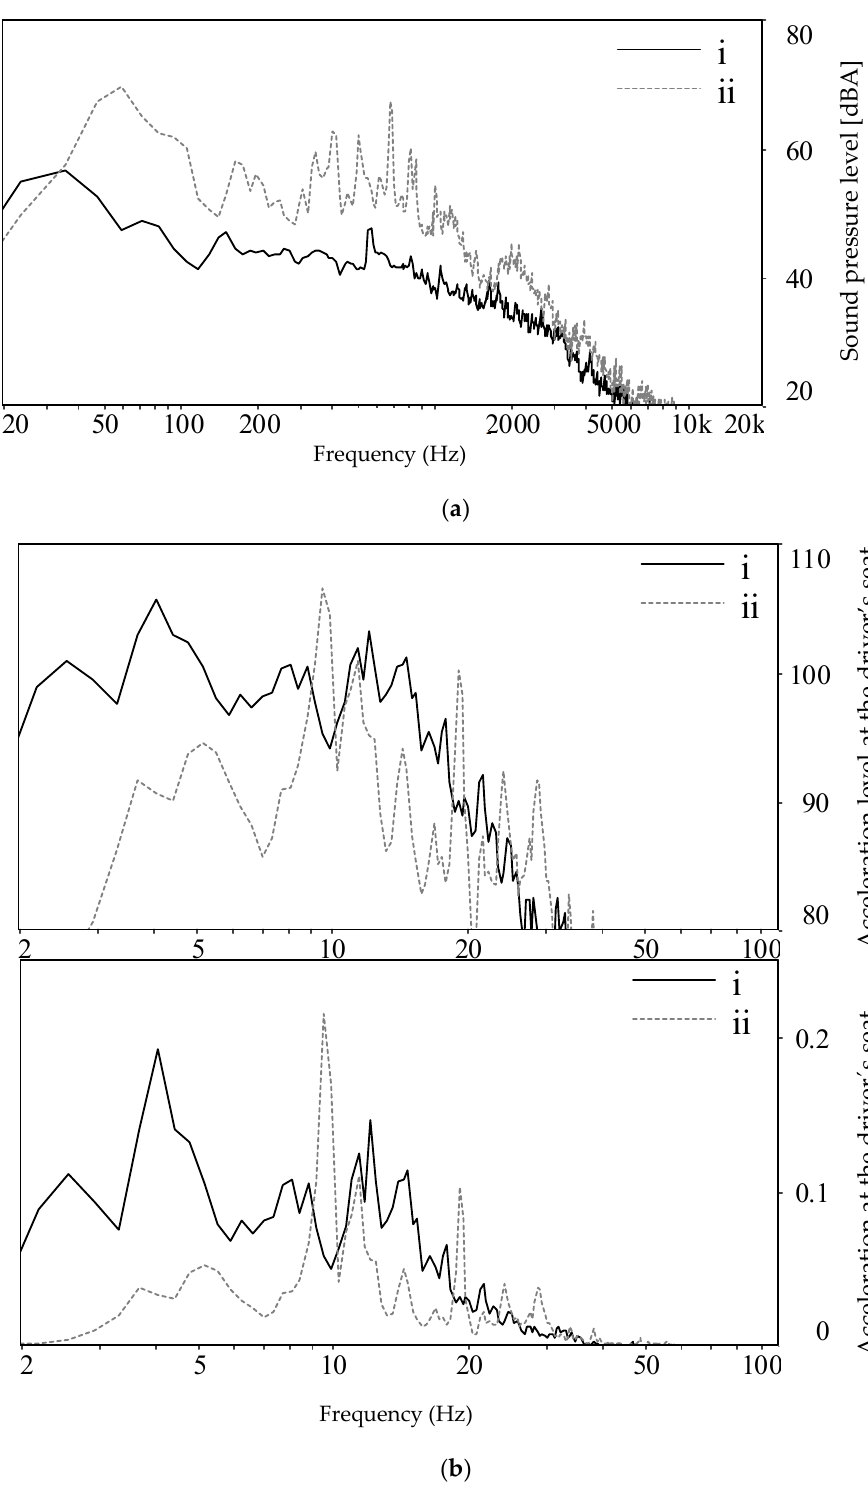
Figure 3. ( a ) Examples of A-weighted frequency spectra (FFT: 4096, 50%, HAN) of the sound pressure level for the (i) refuse collection vehicle on cobblestone and (ii) mini excavator on sand. ( b ) Examples of W k -weighted frequency spectra: (FFT: 32768, 50%, HAN) of the vertical seat vibrations for the (i) refuse collection vehicle on cobblestone and (ii) mini excavator on sand. Figure at the top: acceleration vs. frequency; figure below: acceleration level vs. frequency.